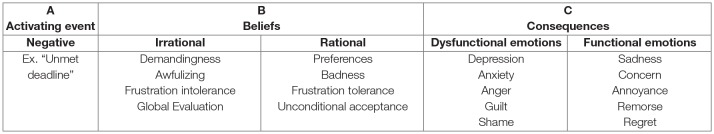
Sequence of the screens in the PsyPills app.